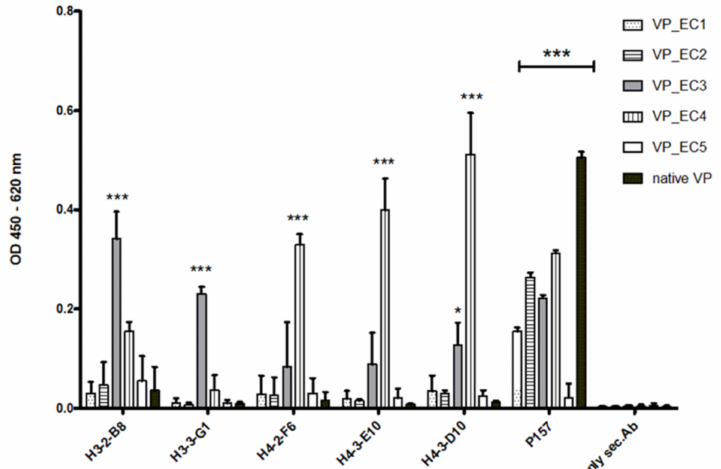
Figure 7. Specific epitope binding of the mAbs to the epitope-engineered VPs. The mAb binding to epitope-engineered VPs with integrated epitopes was measured in immunoassays. Per well, 50 µ L of a 5 µ g/mL VP solution was coated overnight. The wells were washed, blocked with PBS/NKS (5%), and incubated for 1 h with 5 µ g/mL Ab solution. Again, the wells were washed and incubated with HRP-conjugated goat anti-mouse Ab for 30 min. The signals were measured at 450 nm 15 min after adding TMB substrate. The P157 (anti-VP) mAb was used as a positive control. n = 3. * p < 0.05, *** p < 0.001 compared to the control group by